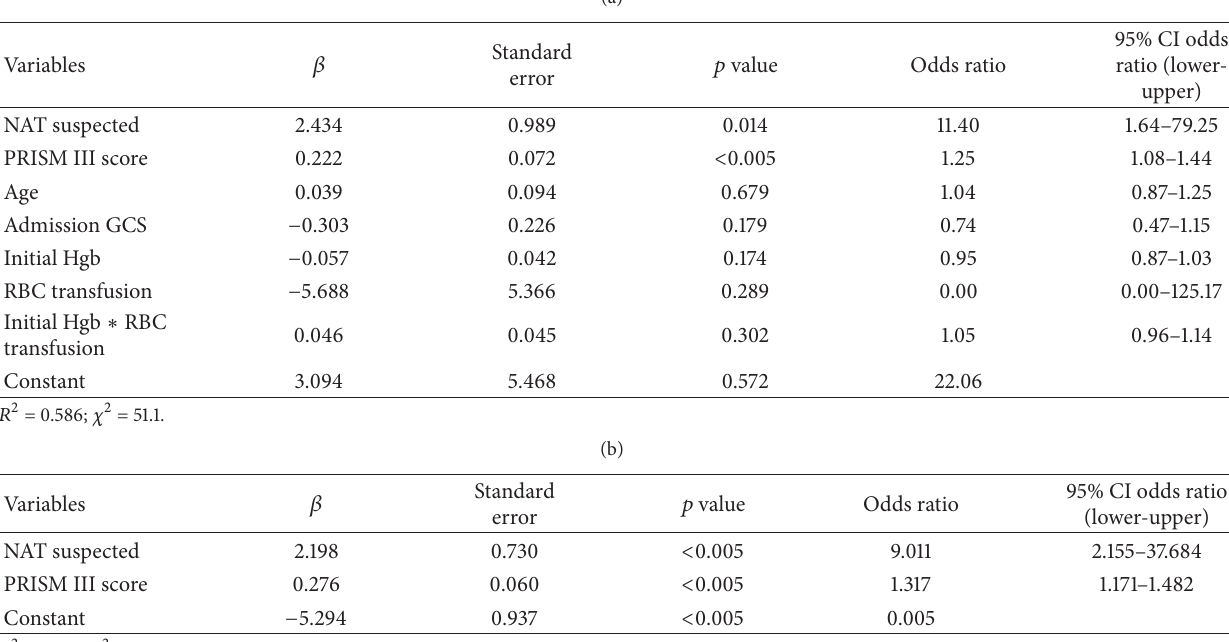
Table 2: Statistical outputs of initial exploratory logistic regression model with seven covariates (a) and final reduced covariate (b) logistic regression model to predict the probability of